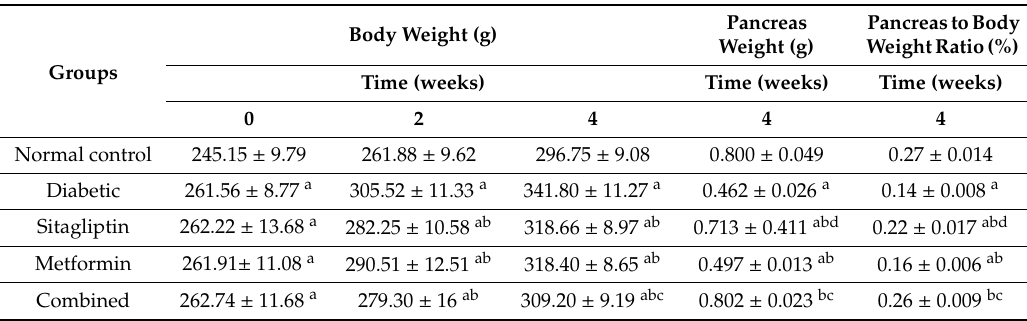
Table 2. Changes in body weight, pancreatic weight, and pancreas / body weight ratio in the di ff erent studied groups during the treatment period after the induction of diabetes (ten days after STZ injection). Week 0 (before starting treatment), week 2, and week 4.